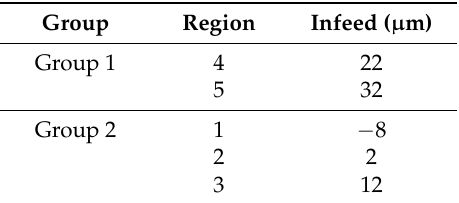
Table 3. Hierarchical clustering (HC) of the different regions using the curves of distribution of T d for